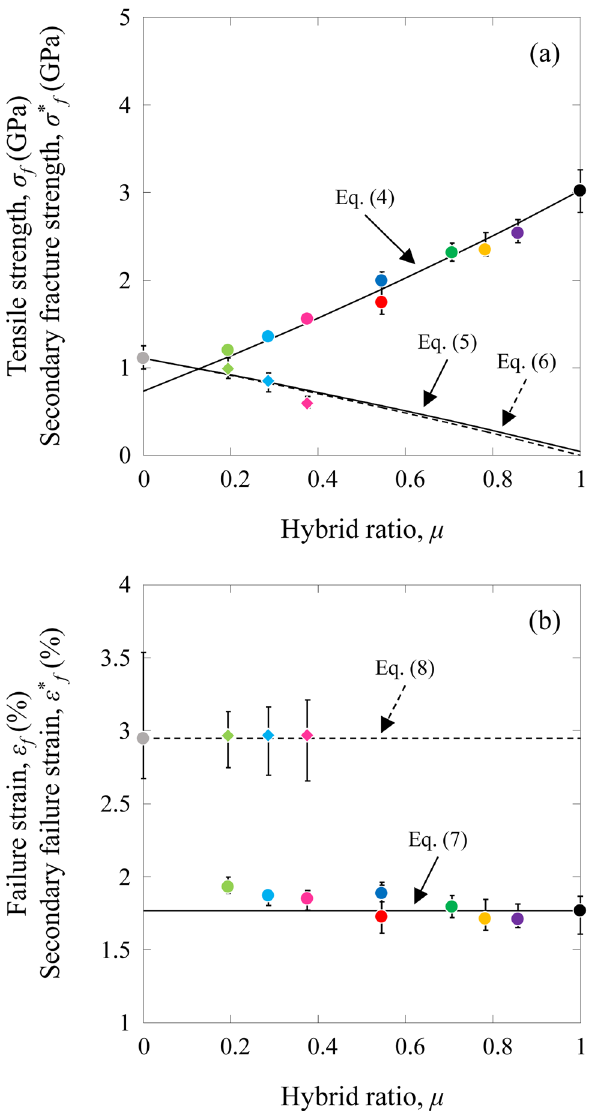
Figure 4. Relation between the tensile strength, secondary fracture strength, failure strain, and secondary failure strain of the HFRP specimens with the hybrid ratio. ( a ) Tensile strength and secondary fracture strength and ( b ) failure strain and secondary failure